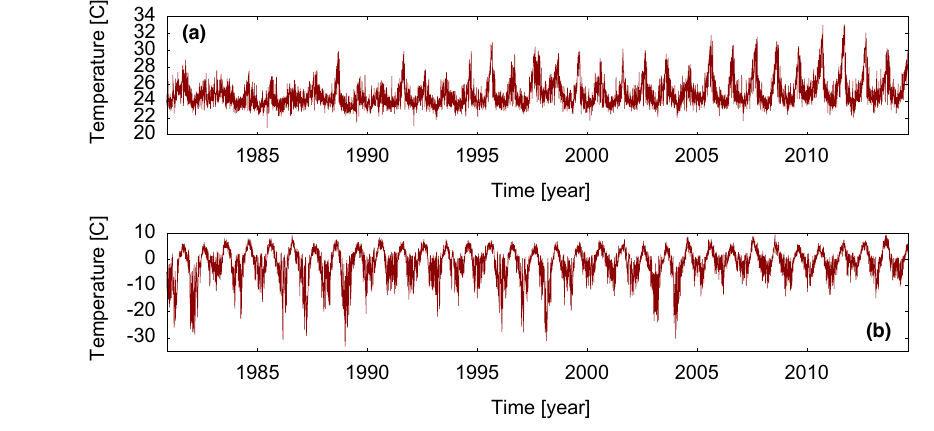
Figure 2.Surface air temperature in two regions where a clear change in the oscillation amplitude in the last ten years, with respect to the first ten years, is observed. (a) Site of coordinates (7.5 S, 307.5 E), marked with a triangle in Fig. 1(c). (b) Site of coordinates (75 N, 40 E), marked with a circle in Fig. 1(c).